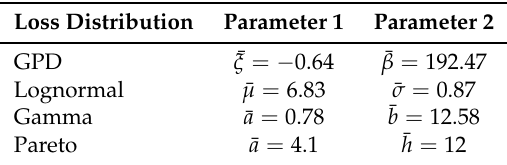
Table 5. Parameters